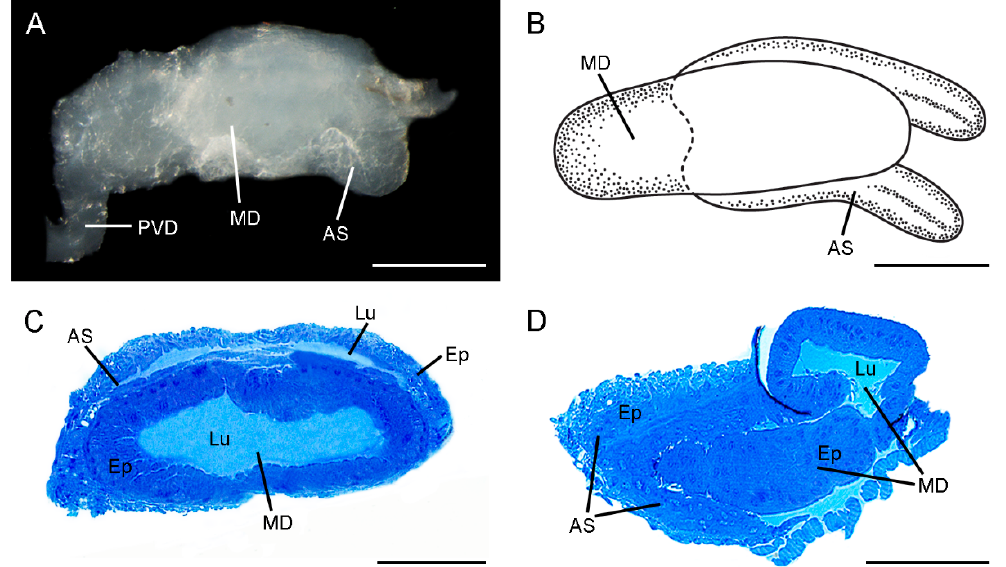
Figure 1. General morphology of the ejaculatory duct of Cerapanorpa nanwutaina . ( A ) Lateral view under LM. ( B ) Schematic diagram of habitus, ventral view. ( C ) Cross section showing the epithelia and lumens in the median duct and symmetrical accessory sac. ( D ) Longitudinal section of posterior part, showing that the symmetrical accessory sac partially encloses the median duct. AS, accessory sac; Ep, epithelium; MD, median duct; PVD, post-vesicular vas deferens. Scale bars: ( A , B ) = 200 µ m; ( C , D ) = 100 µ